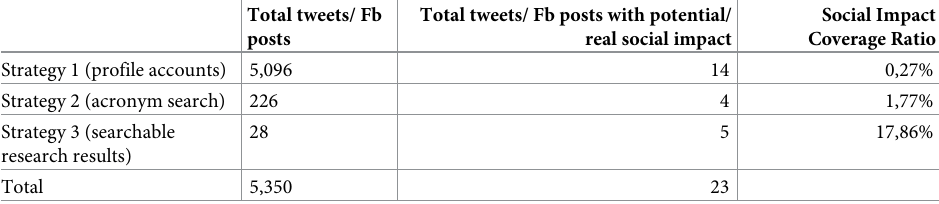
Table 13. Social impact coverage ratio per search strategy.